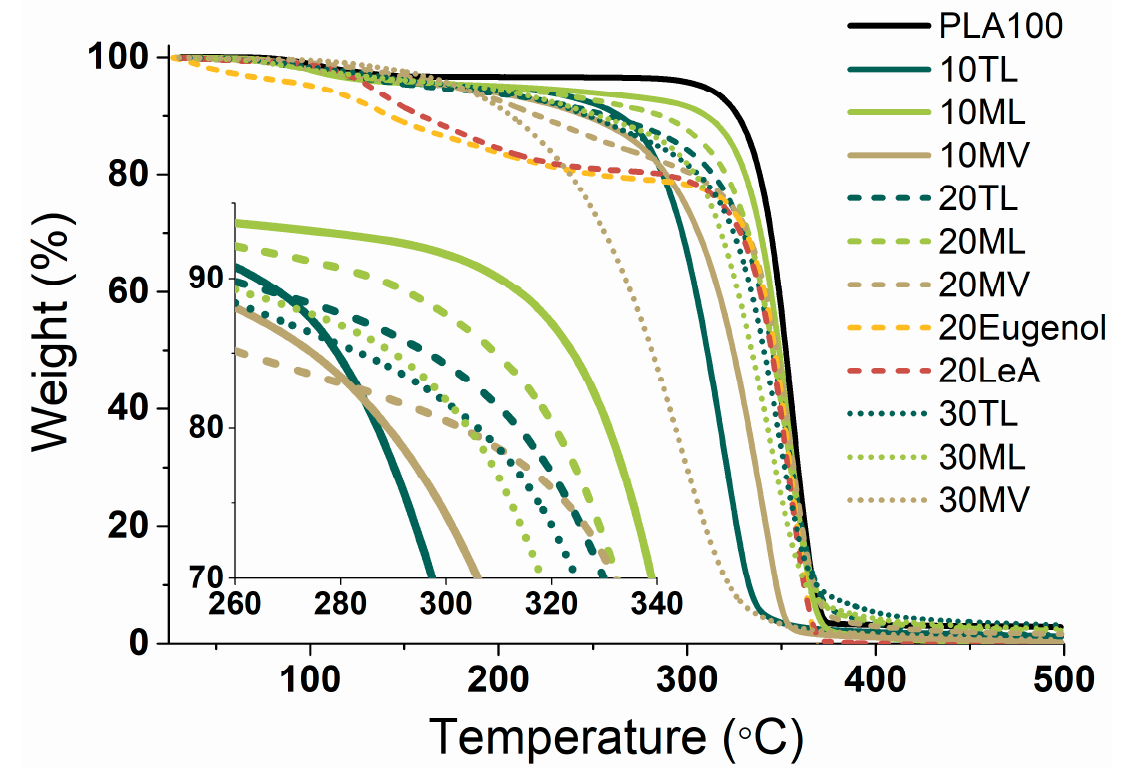
Figure 4. TGA curves of neat PLA and its blends.